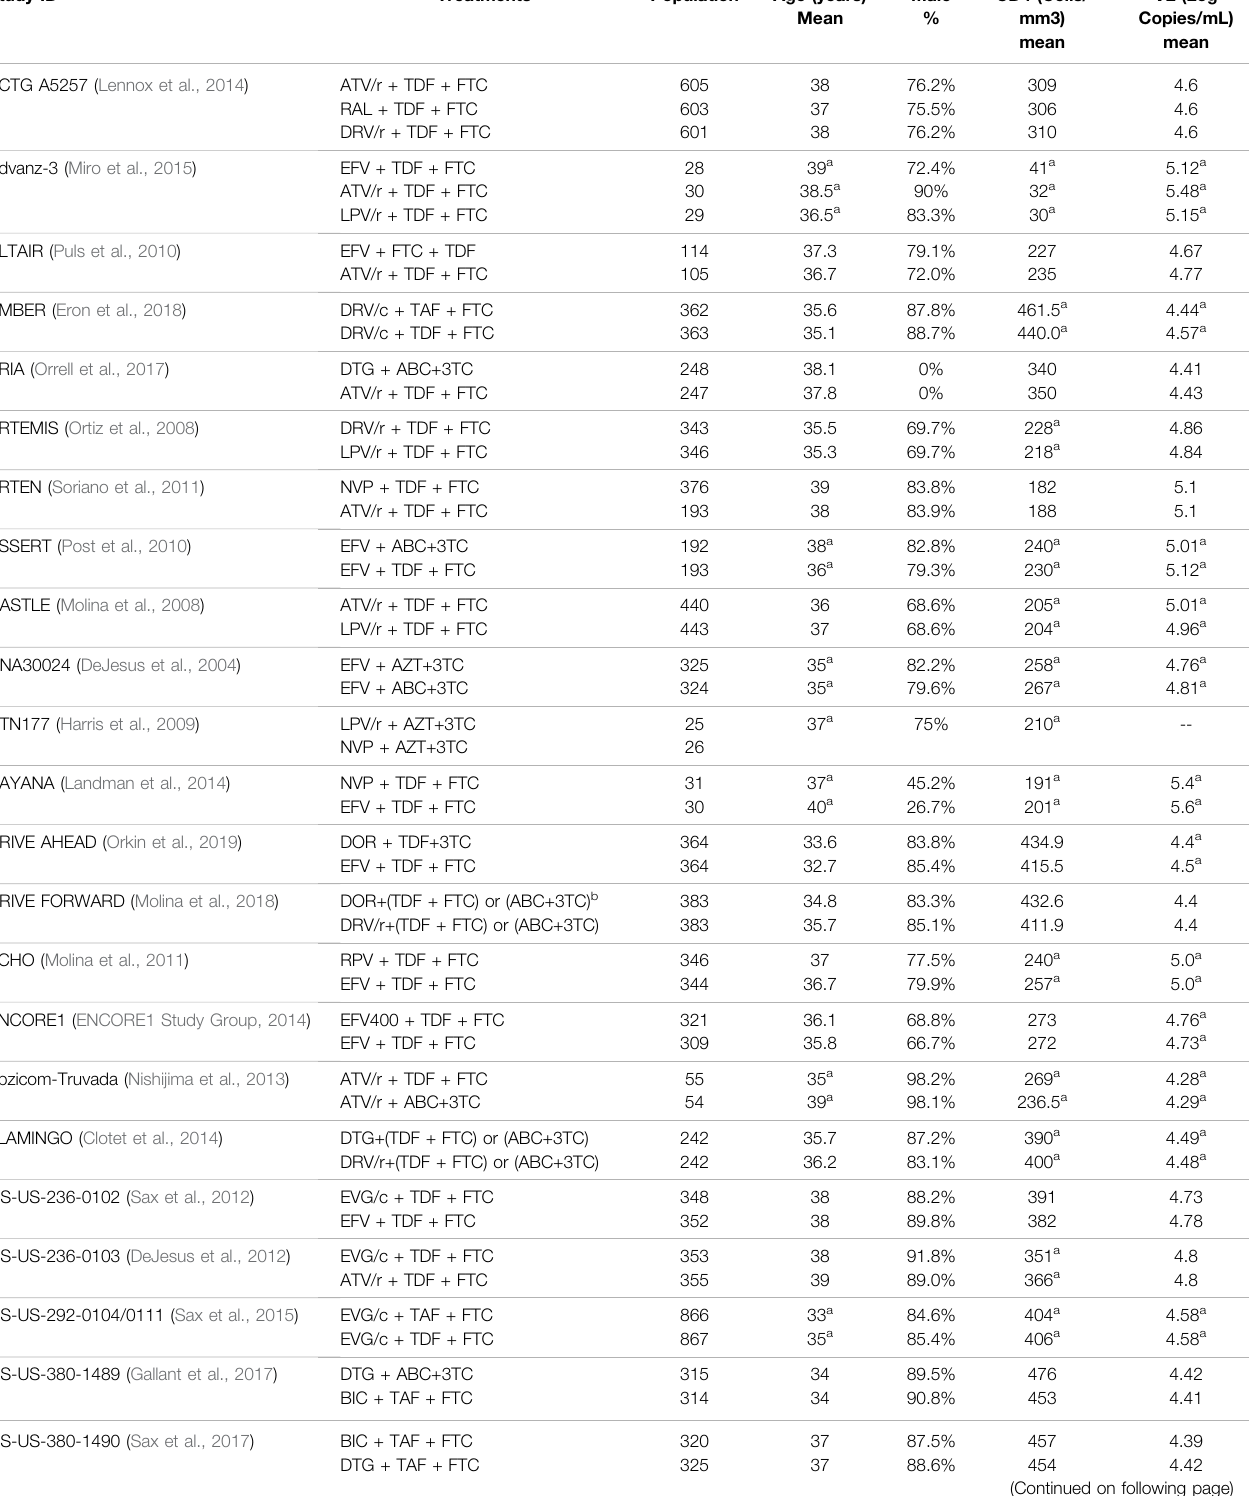
TABLE 1 | Information of the trials and baseline characteristics of